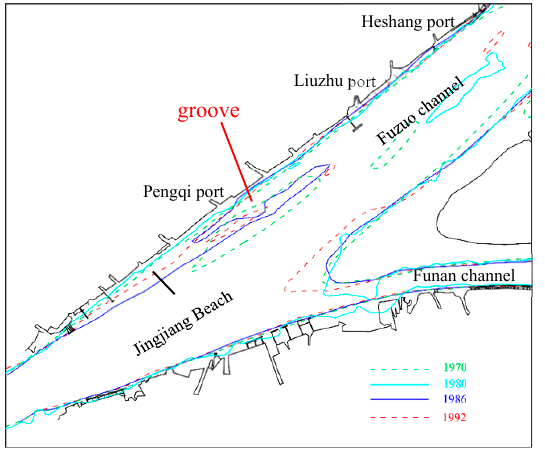
Figure 8. 10 m isobath of the Fujiangsha reach when the grooves related to the flood tidal current appear.